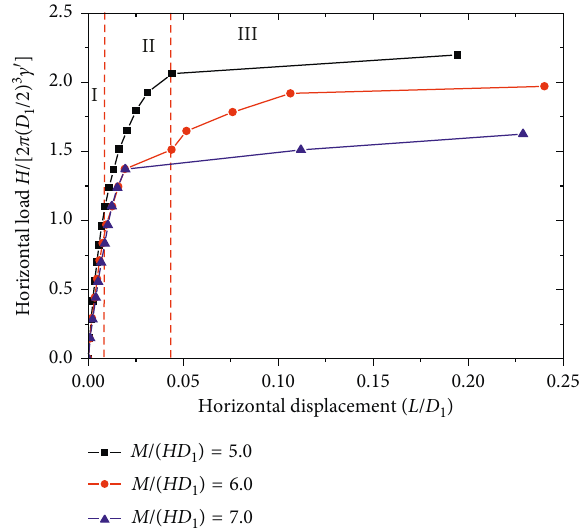
Figure 7: Horizontal displacement-horizontal load curves under different M /( HD 1 ) values for cone-shaped foundation.